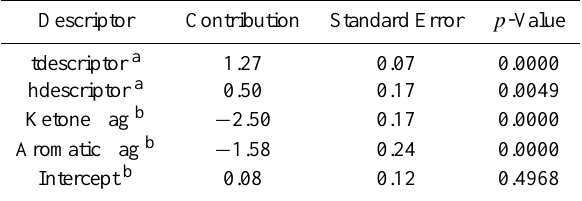
Table 3. Descriptors for the model to estimate hydration constants and their related contribution, standard error and statistical signifi- cance (p-value) in the